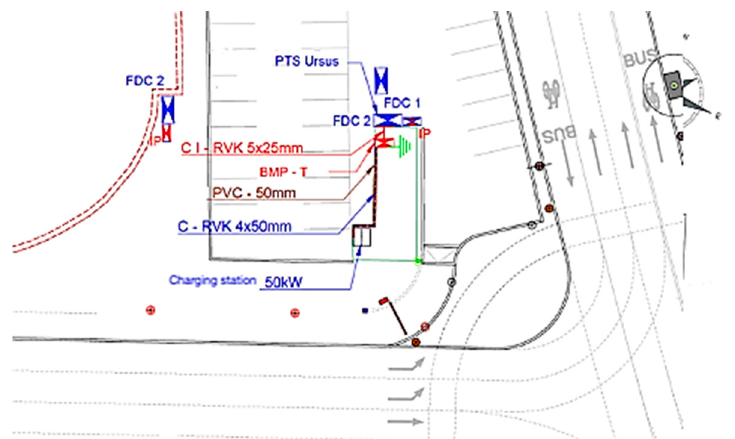
Figure 3. Supply plan for the EV charging station in Unirii Square [13].